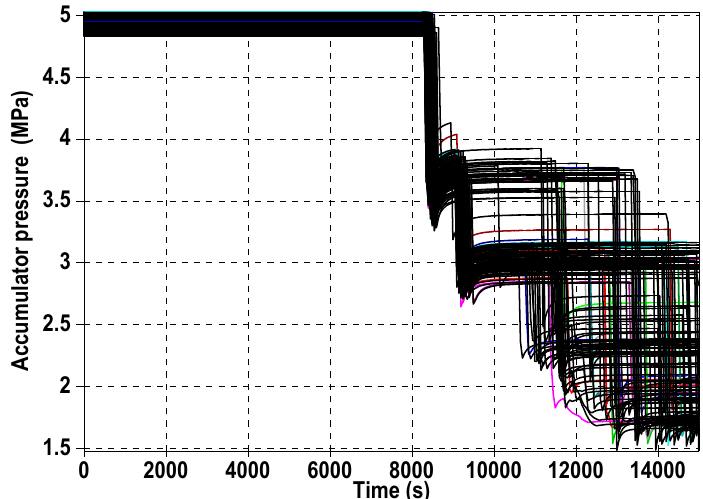
Figure 5. Accumulator pressure.